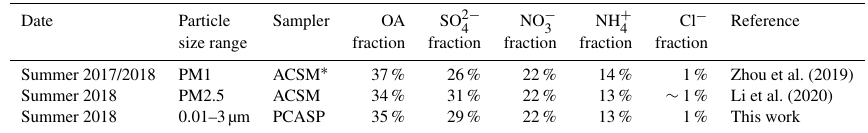
Table B3. The observed mass fractions of different aerosol compositions in Beijing, China, in two previous studies, as well as the assumed fractions used in this